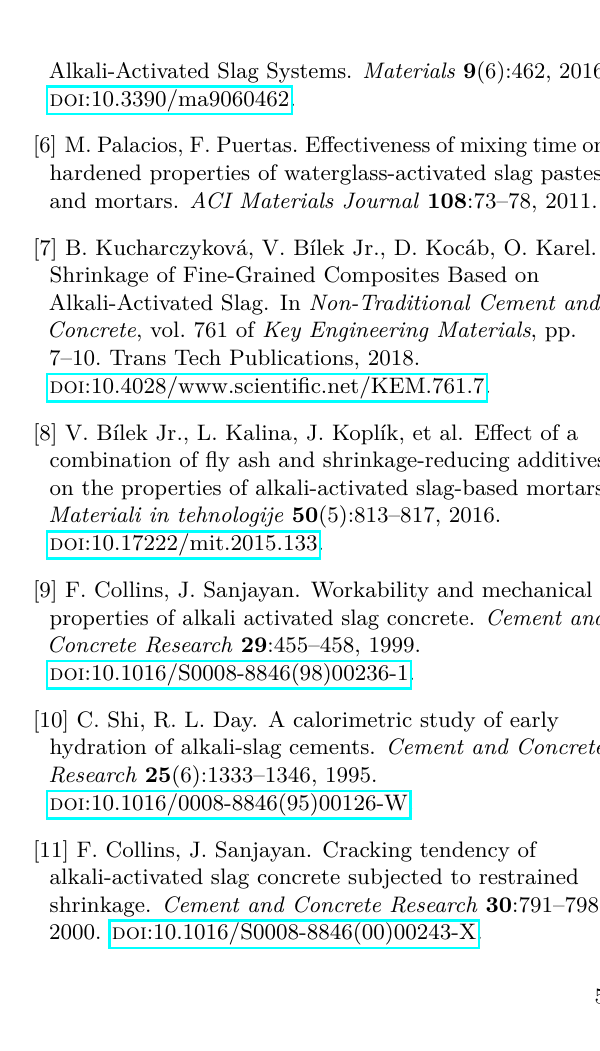
Figure 7. Development of the Young’s modulus E